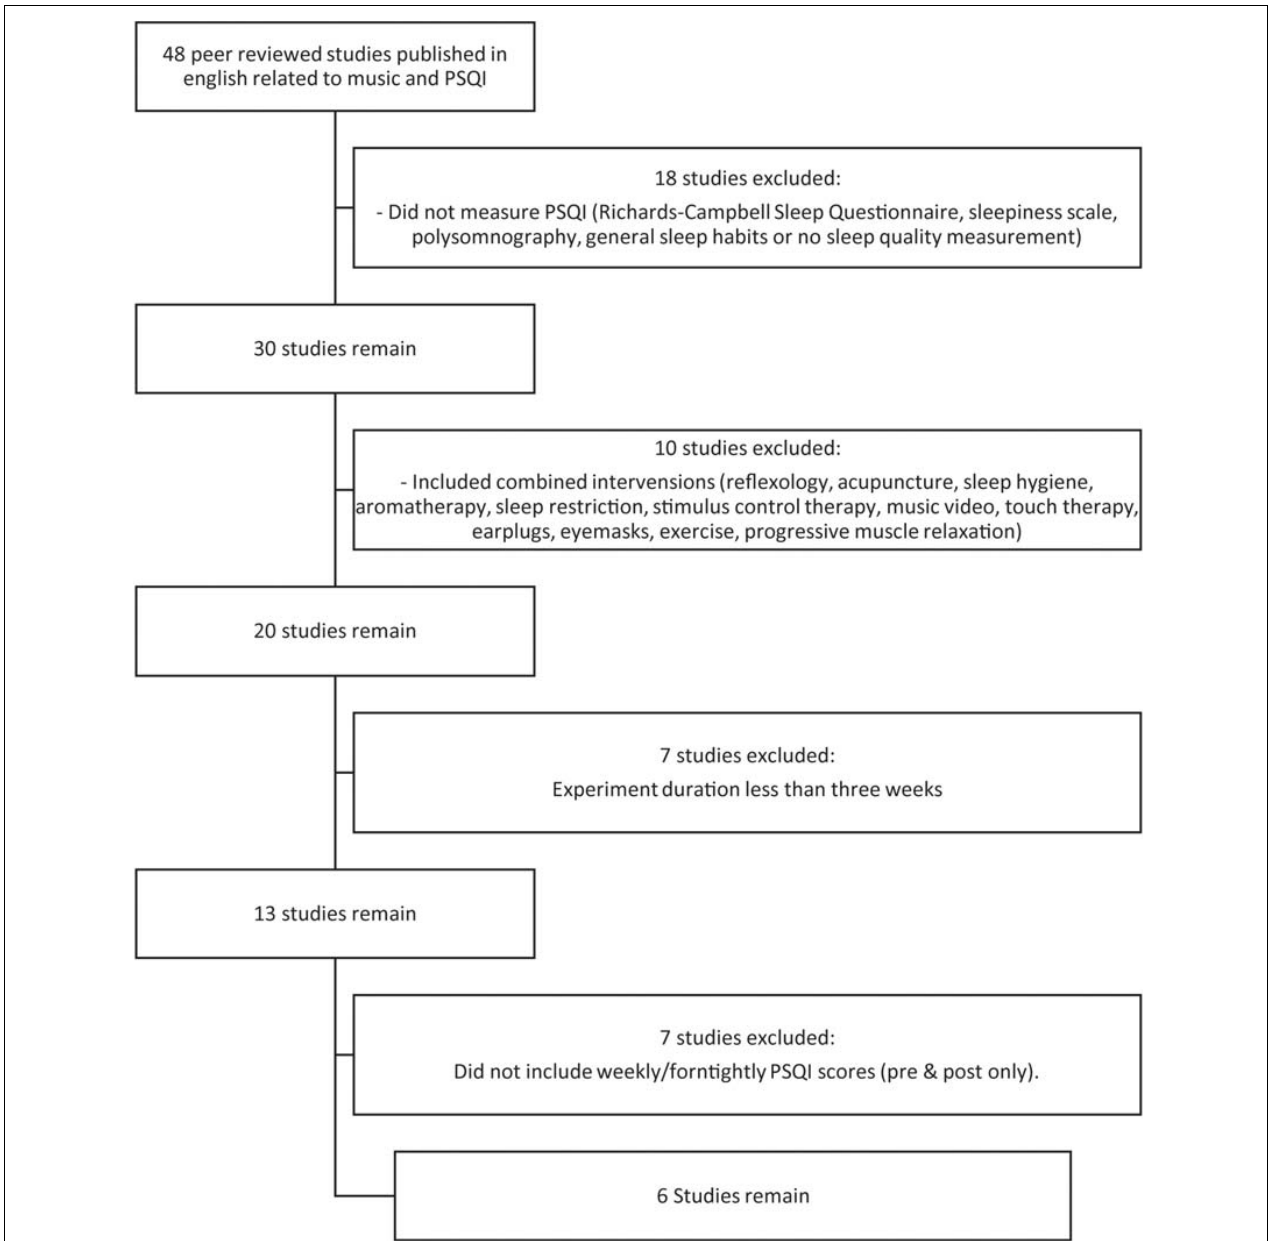
FIGURE 1 | Flowchart of selection of reviewed